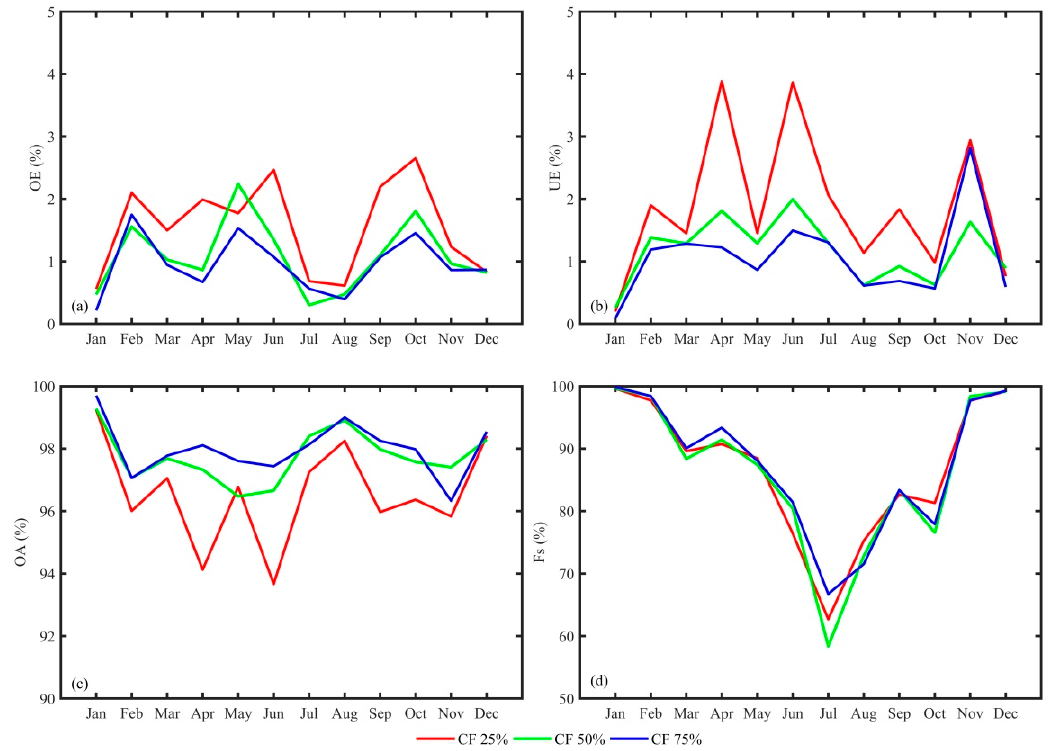
Figure 5. Quantitative evaluation results with the cloud assumption.